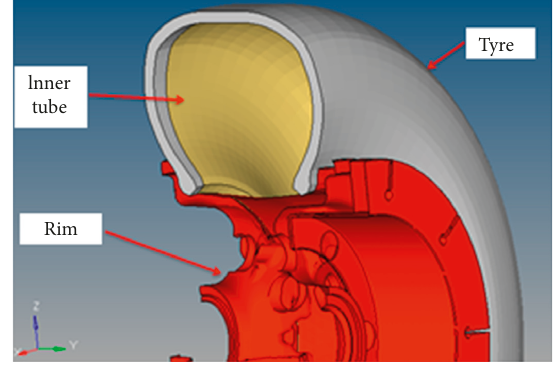
Figure 23: Modelling of the